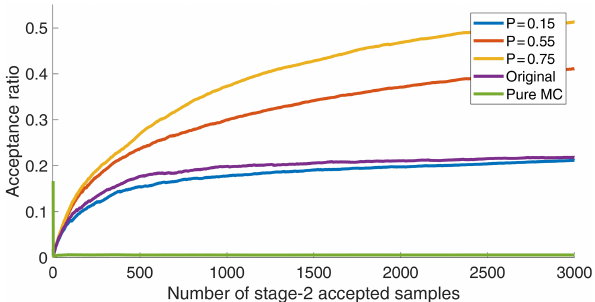
Figure 3. Acceptance ratios of the different sampling schemes, plot- ted as a function of the number of stage-2 accepted